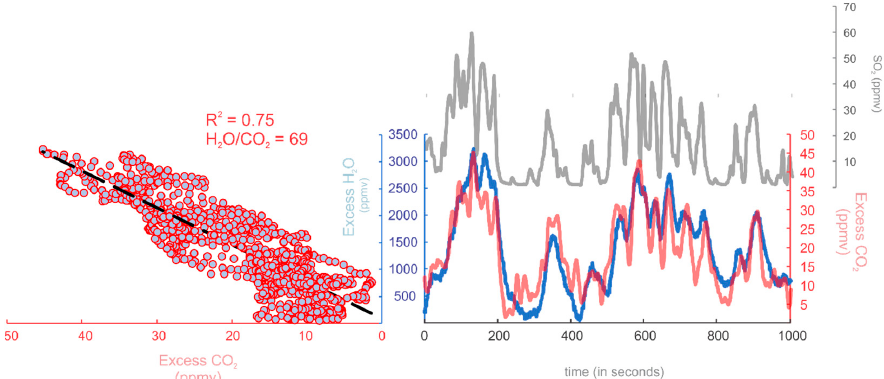
Figure 4. On the left: scatter plot of H 2 O vs. CO 2 mixing ratio in the Mount Garet plume; the least-square regression line is shown as black dashed line on each plot (R 2 = 0.75). On the right: concentration (ppmv) time series of H 2 O (blue) and CO 2 (red) recorded at a frequency of 1 Hz; in black, SO 2 concentration (ppmv) is given as an analog for plume density during our measurement period.